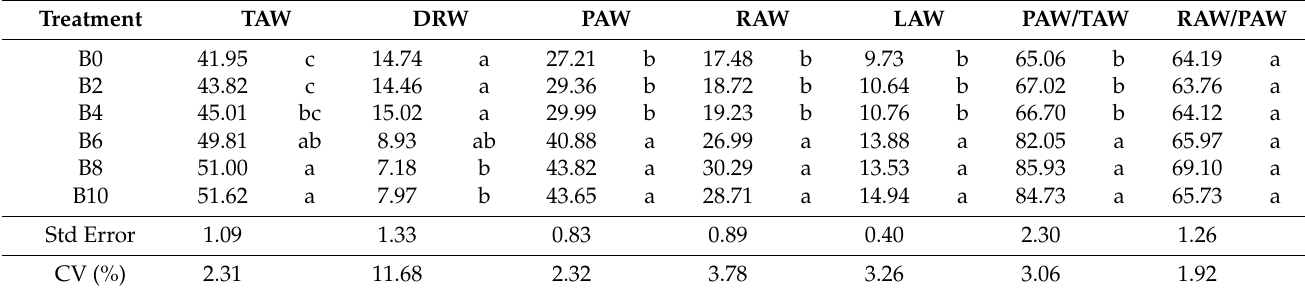
Table 4. Capacitive indicators (%) for the six soil–biochar mixtures (treatments). Treatment TAW